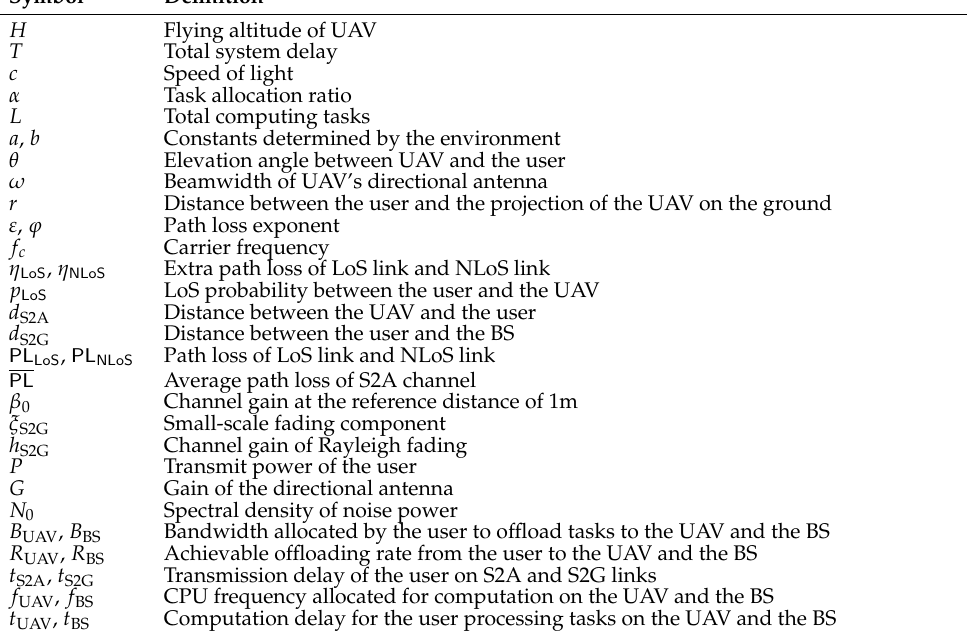
Table 1. List of